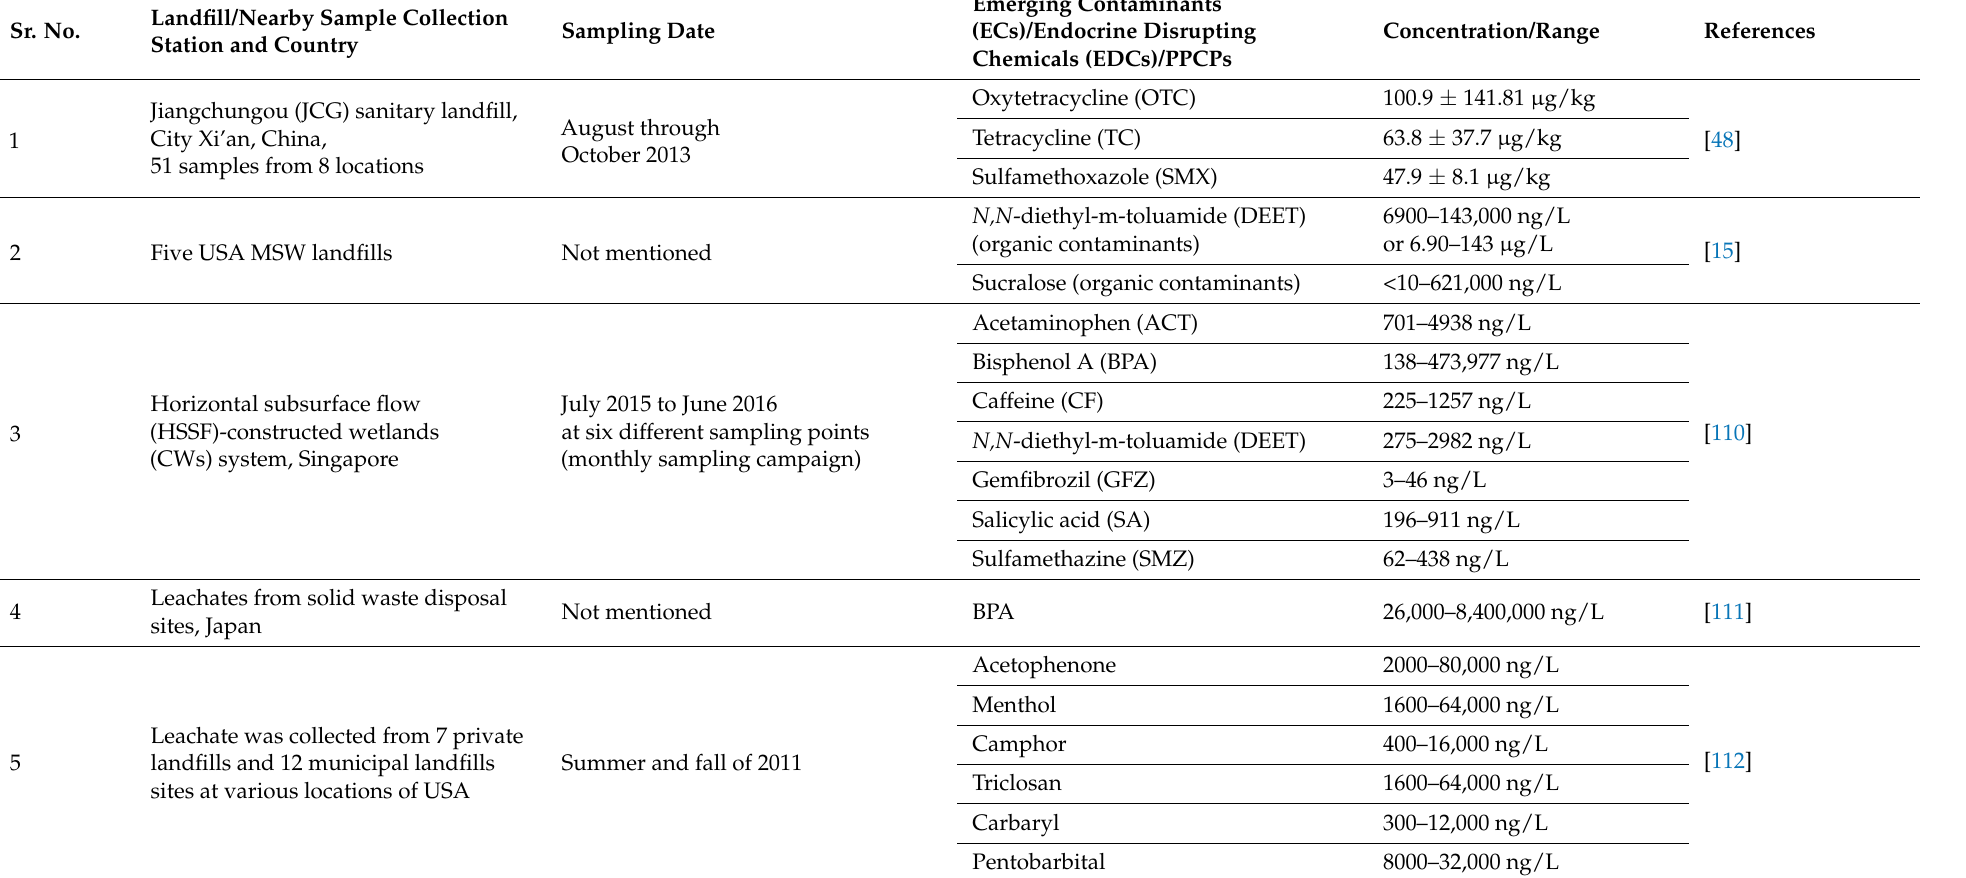
Table 2. The detection of pharmaceutical and personal care products (PPCPs), emerging contaminants (ECs), and endocrine-disrupting chemicals (EDCs) in landfill leachate and nearby groundwater environments. MSW: municipal solid waste.